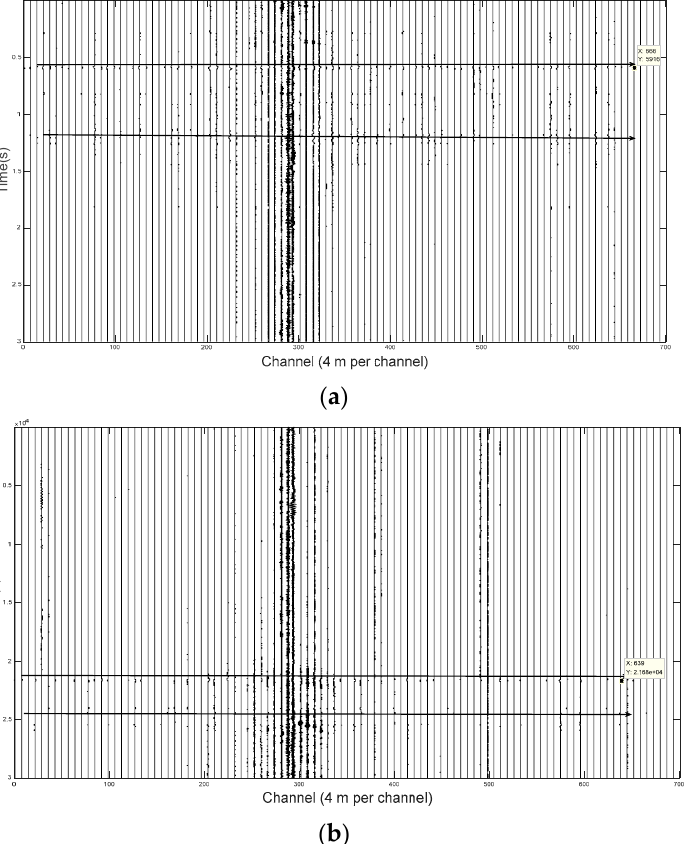
Figure 6. ( a ) Aircraft A vibration signal time delay in different locations of the optic fiber; ( b ) Aircraft B vibration signal time delay in different locations of the optic fiber.